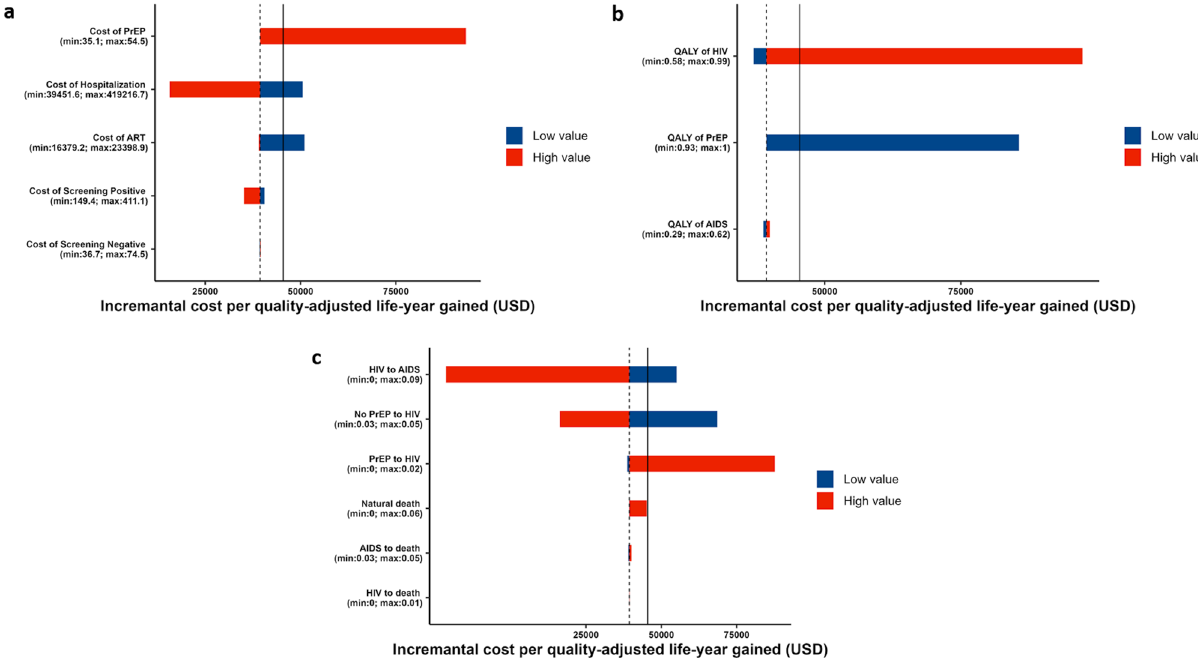
Figure 5. Cost-effectiveness evaluation of the pre-exposure prophylaxis (PrEP) program. The incremental cost per QALY gained (also known as incremental cost-effectiveness ratio [ICER]) in the 15 years since the introduction of the PrEP program with varied parameter values was calculated. Incremental cost varying each cost, QALYs, or transition parameter. The black solid vertical lines represent the cost-effectiveness threshold frequently referred to in Japan (5.0 million JPY, or 45,454.5 USD). The black dashed vertical lines represent the base case scenario (4.3 million JPY per QALY gained). Therefore, the values on the left of the base case scenario correspond to more favorable scenarios compared with baseline. Blue bars represent parameter values lower than baseline, and red bars represent parameter values higher than baseline. For example, when the cost of PrEP increased (red bar), the incremental cost also increased, which is not favorable. PrEP coverage was assumed to be 50%. ( a ) Cost parameters were varied: the cost of PrEP pills, cost of hospitalization due to AIDS, cost of ART for those infected by HIV, cost of screening for the HIV-positive population, and cost of screening for the HIV- negative population. ( b ) QALY parameters varied: QALYs for people with PrEP, people living with HIV, and AIDS. ( c ) The transition probabilities of the Markov model also varied. For the transition probability from PrEP to HIV, the PrEP efficacy was varied.